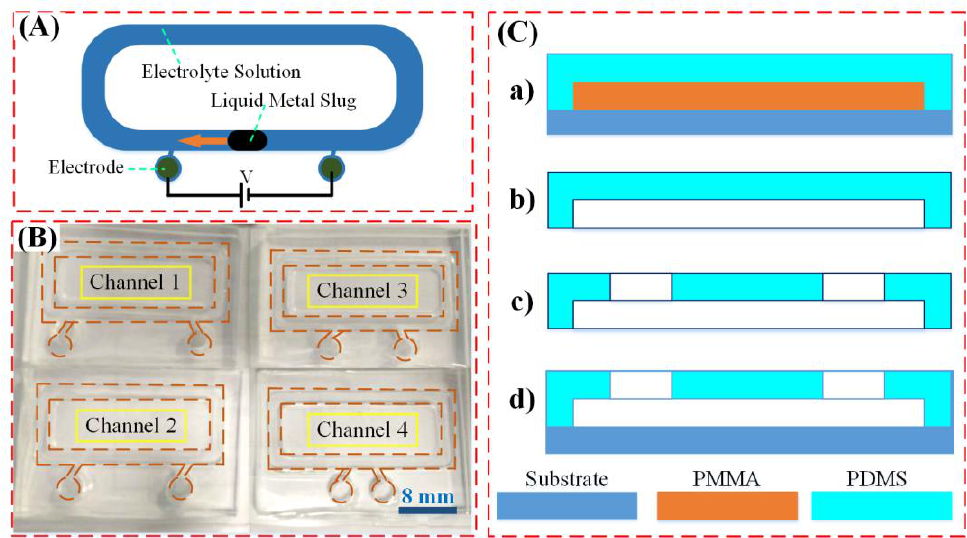
Figure 1. Chip design and fabrication processes of the liquid metal-based actuation device. ( A ) The chip structure of the liquid metal actuation device. ( B ) Image of the PDMS channel used for liquid metal pumping. ( C ) The fabrication process of the presented device.